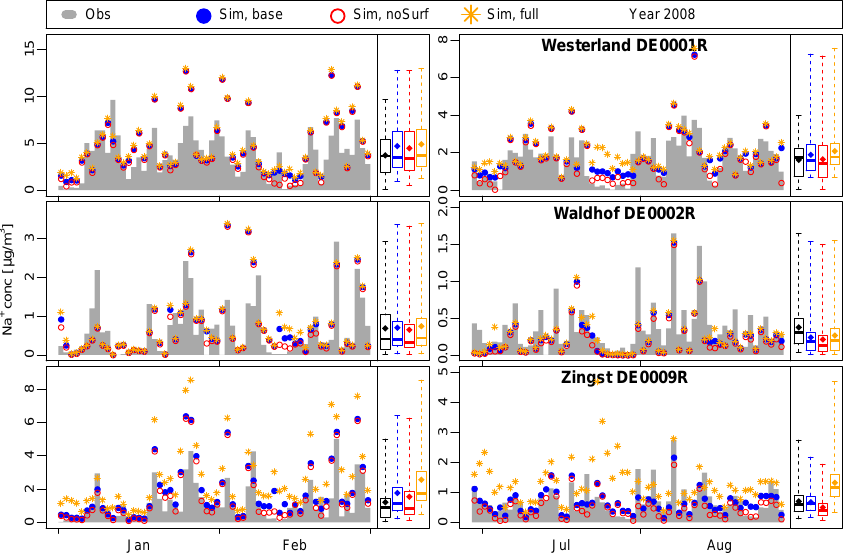
Figure 5. Measured (gray bars and black box plots) and modeled (colored symbols) sodium concentrations at three stations (top to bottom) during winter 2007/08 (left) and summer 2008 (right). The orange line indicates sodium concentrations without salinity-dependent down- scaling of sea salt emissions. On the left of each plot, the time series of the data are plotted. To the right of each time series, box plots showing the minimum, 25% percentile, median, 75% percentile, maximum, and mean values (rhombus) are